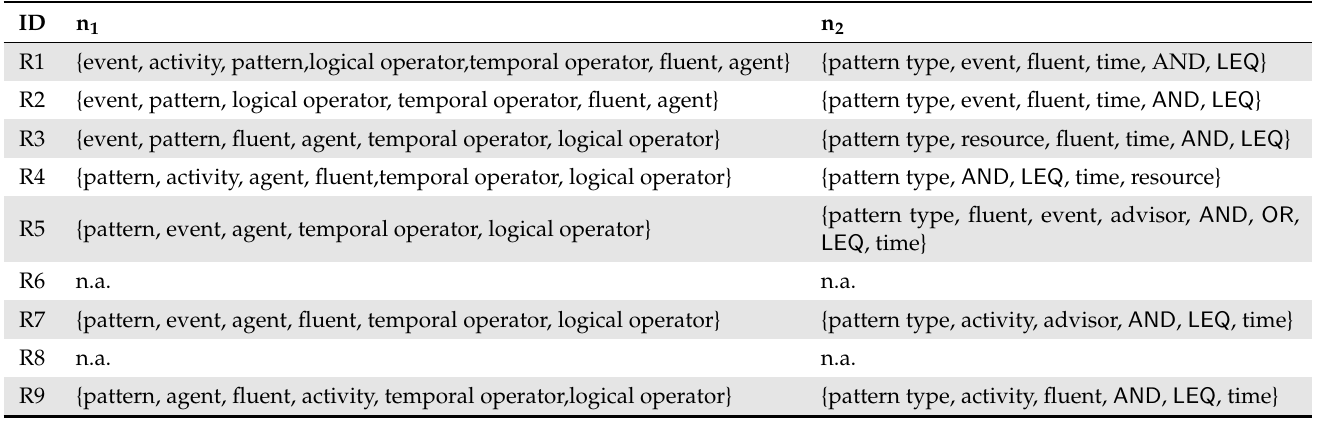
Table A11. Definitions on PENELOPE .